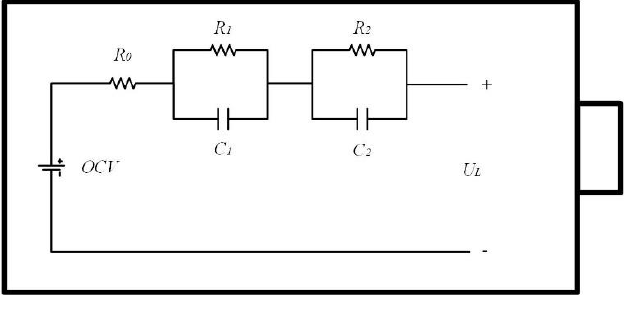
Figure 3. The 2-RC ECM. Figure 3. The 2-RC Based on the 2-RC ECM, the state equation (Equation (4)) and measurement equation (Equation (5)) could be obtained using the Kirchhoff voltage and current laws.